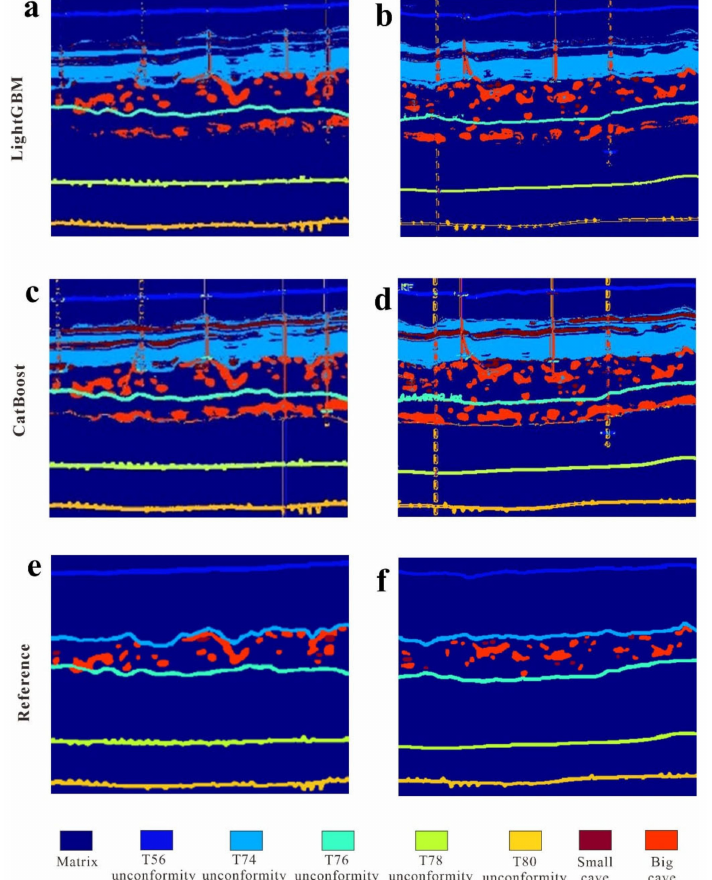
Figure 10. Comparison of images predicted by LightGBM ( a , b ), CatBoost ( c , d ), and reference images 2520 ( e ), 7490 ( f ) in case B.